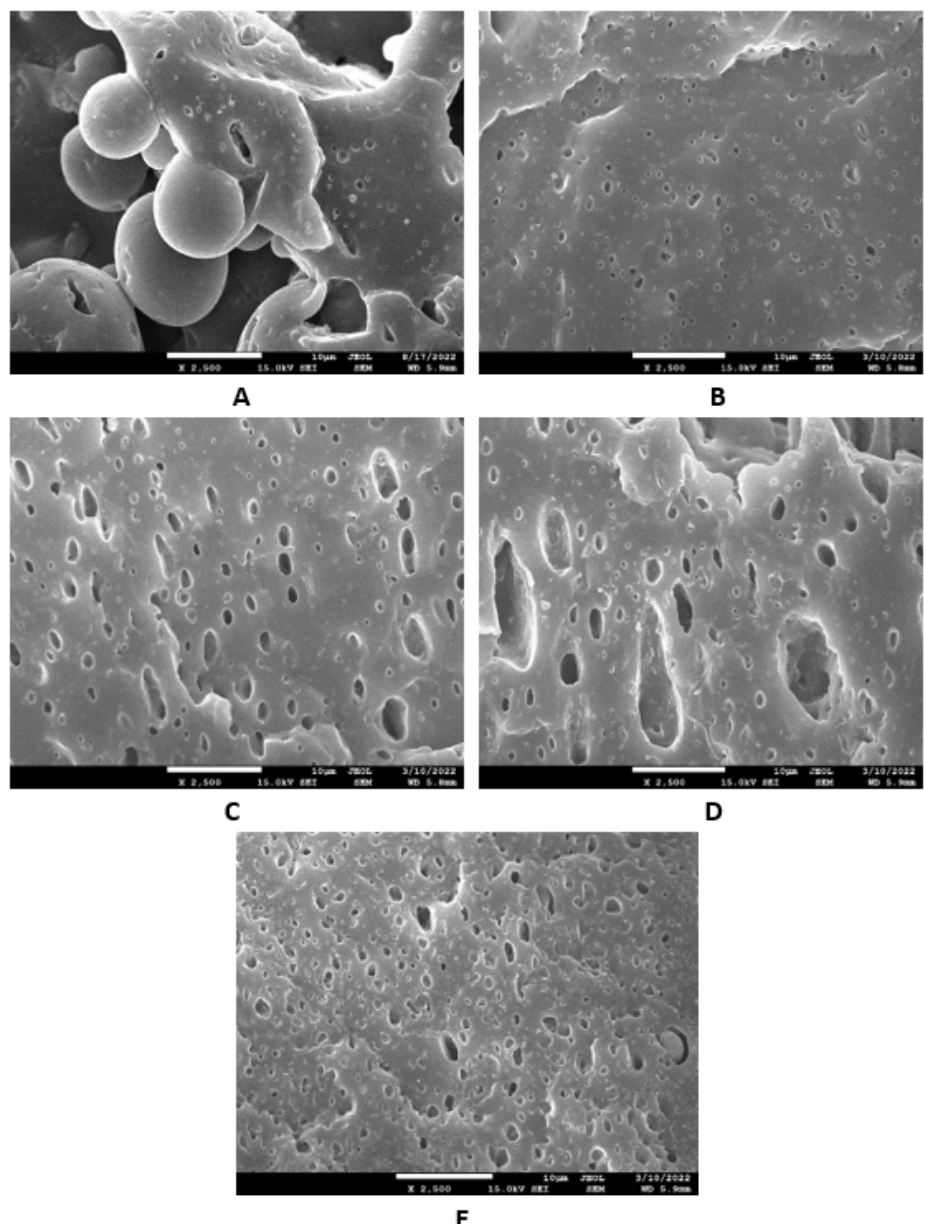
Figure 20. SEM images of vulcanizates NBR-L30 after washing in boiling water: ( A ) reference vulcanizate without glycerol, ( B ) vulcanizate with 5 phr of glycerol, ( C ) vulcanizate with 10 phr of glycerol, ( D ) vulcanizate with 15 phr of glycerol and ( E ) vulcanizate with 20 phr of glycerol.